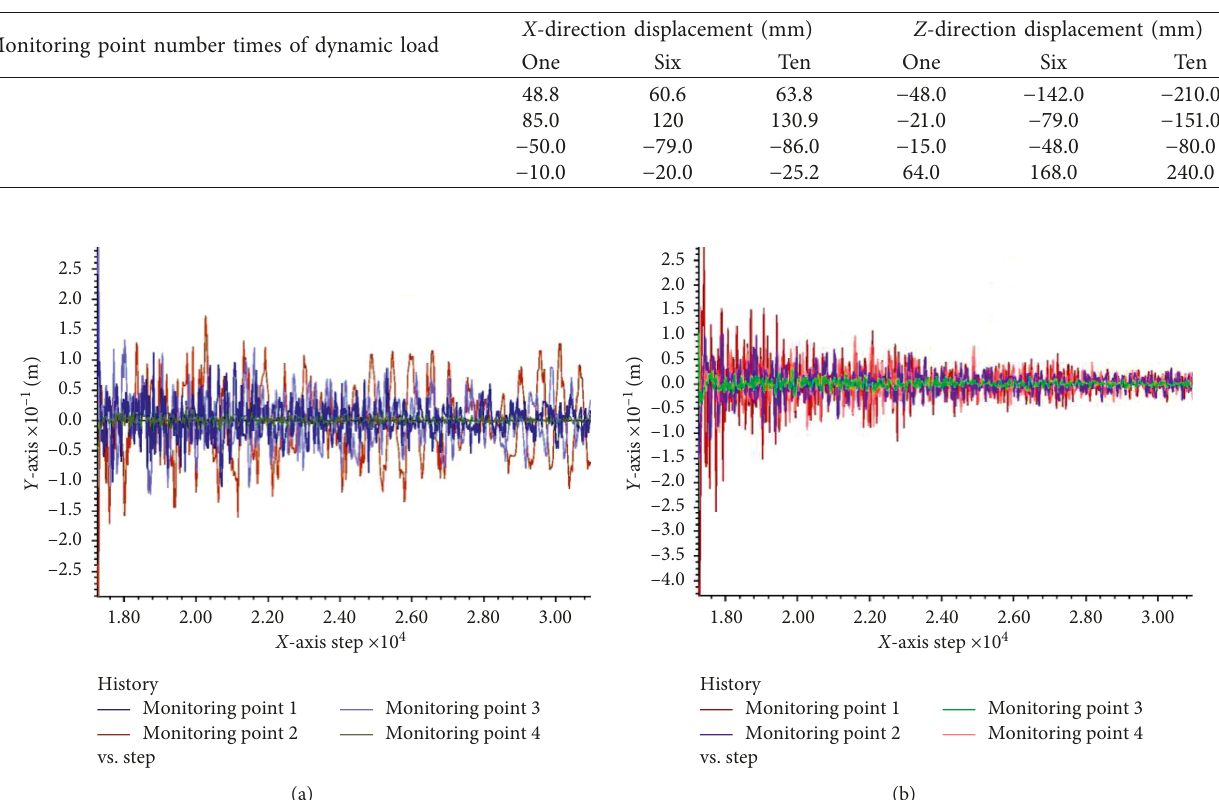
Figure 7: Displacement response diagrams after ten dynamic loads. (a) X -direction displacement and (b) Z -direction displacement. Table 2: Displacement monitoring result record.